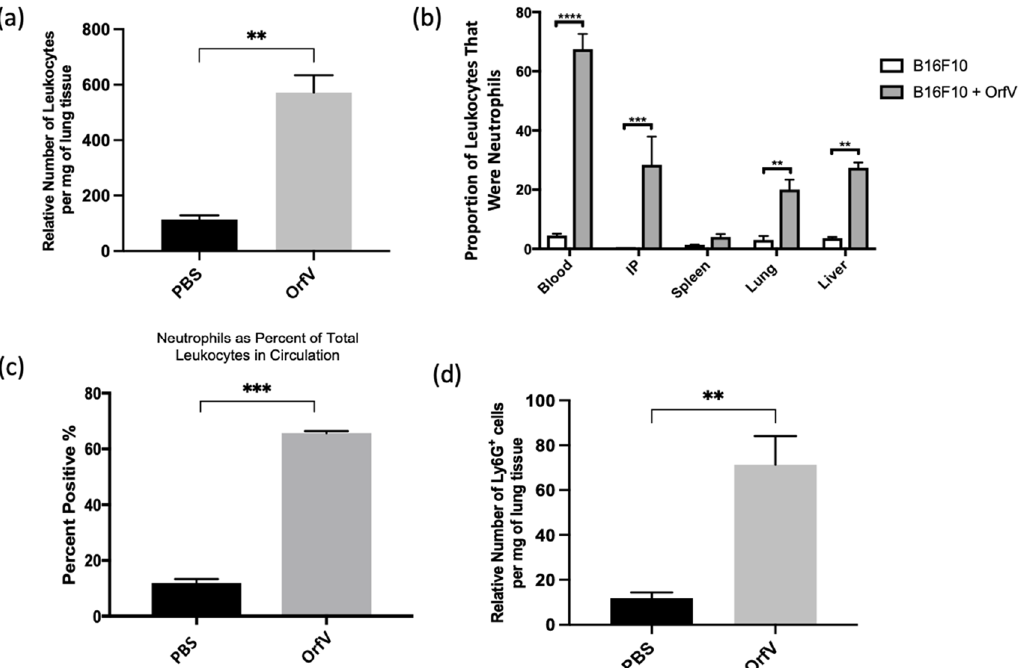
Figure 1. Intravenous delivery of OrfV recruited leukocytes to tumor-bearing lungs and activated systemic neutrophil responses. Seven- to nine-week-old female C57BL/6 mice ( n = 8 per group) were injected intravenously with 3 × 10 5 B16F10 melanoma cells to simulate pulmonary metastases. Four days post-tumor challenge, mice were injected intravenously with 5 × 10 7 plaque-forming units of OrfV or phosphate-buffered saline (PBS) and euthanized 24 h later: ( a ) the number of leukocytes in the lungs was quantified via flow cytometry based on size exclusion and surface expression of the pan-leukocyte marker CD45; ( b ) the proportion of neutrophils, designated as CD45 + Ly6G hi CD11b hi , relative to total live cells in the blood, intraperitoneal cavity, spleen, lungs, and liver was determined via flow cytometry; ( c ) the percentage of CD45 + leukocytes that were Ly6G hi CD11b hi neutrophils in circulation was quantified through flow cytometry; ( d ) the number of neutrophils in the lungs was quantified through flow cytometry based on having a CD45 + Ly6G hi CD11b hi phenotype. Statistical analysis was performed with two-tailed Student’s t -test for ( a , c , d ) and one-way analysis of variance in the case of ( b ). Statistical significance was designated as ** p ≤ 0.01, *** p ≤ 0.001, and **** p ≤ 0.0001.